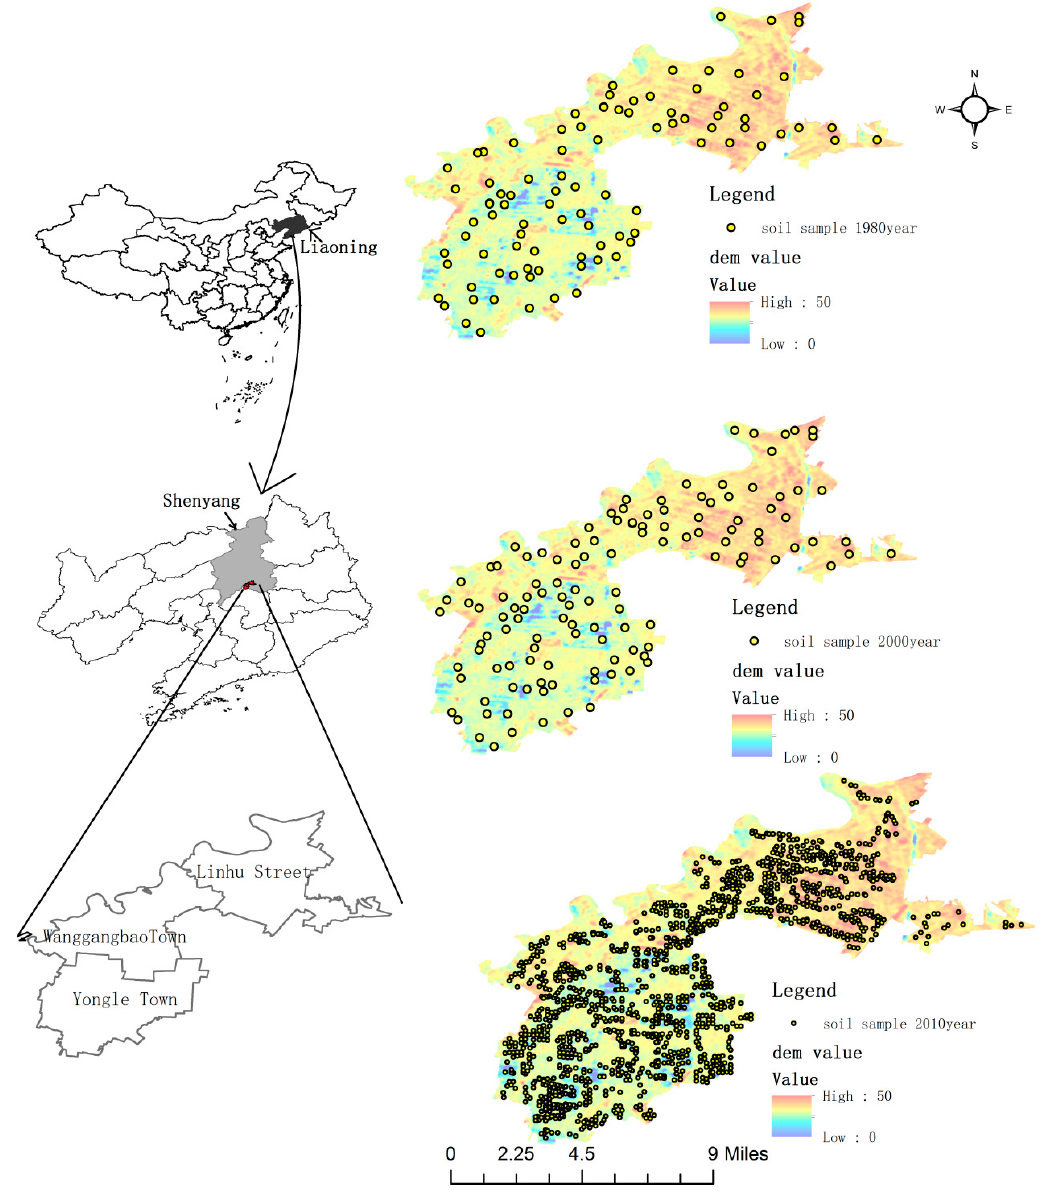
Figure 2. Study area map and spatial distribution of soil sampling points in 1980, 2000, and 2010.